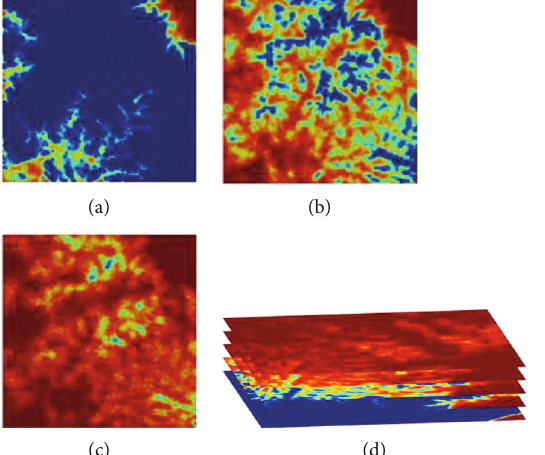
Figure 6: Total cost considering the dynamic threats.